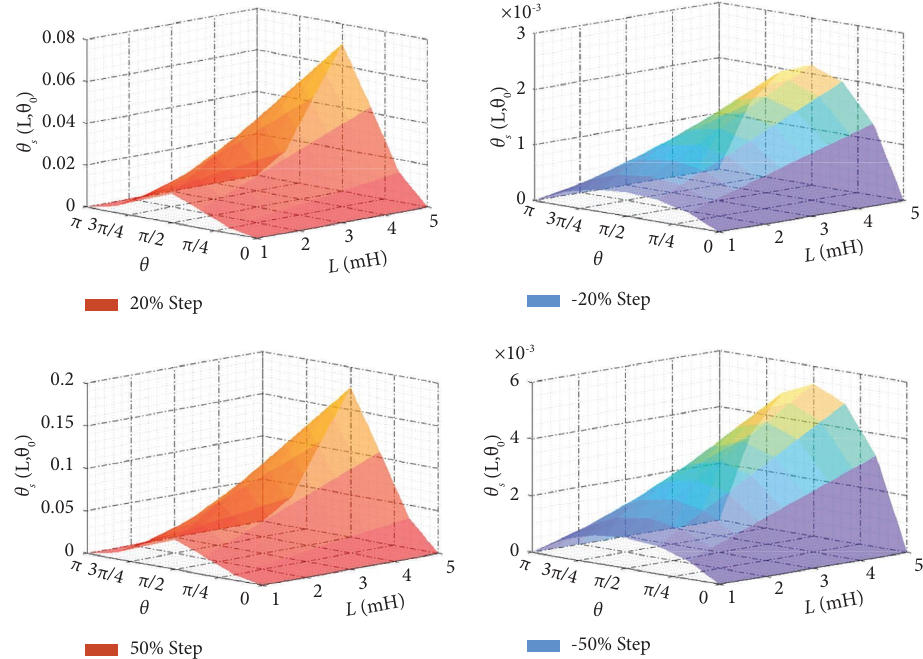
Figure 8: Te settling time with the on-line trajectory controller under diferent inductance and load current step change.